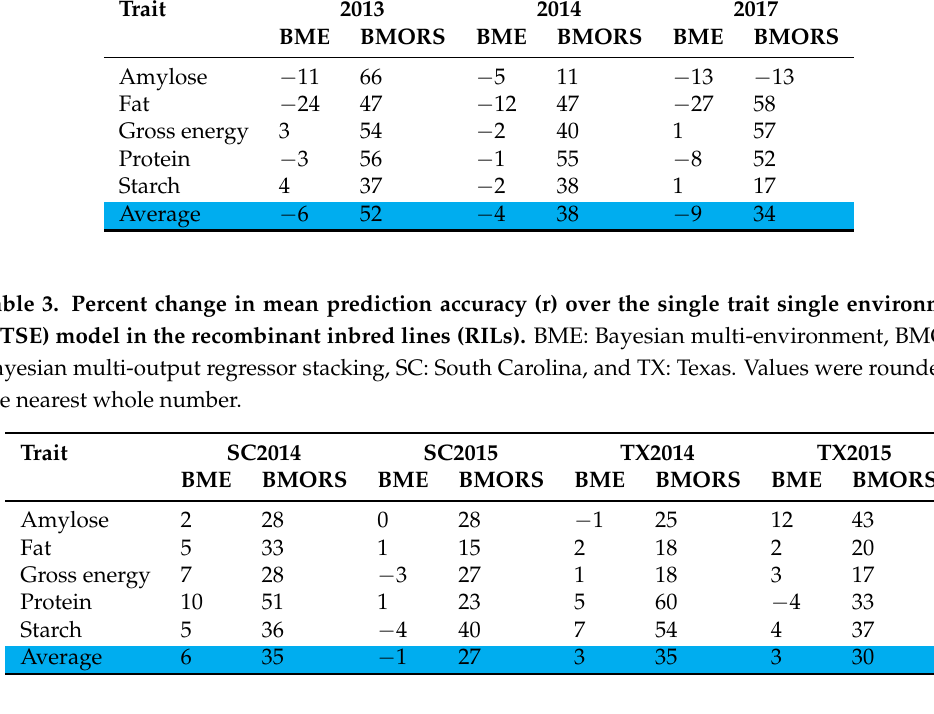
Table 2. Percent change in mean prediction accuracy (r) over the single trait single environment (STSE) model in the diversity panel (GSDP). BME: Bayesian multi-environment, and BMORS: Bayesian multi-output regressor stacking. Values were rounded to the nearest whole number. Trait